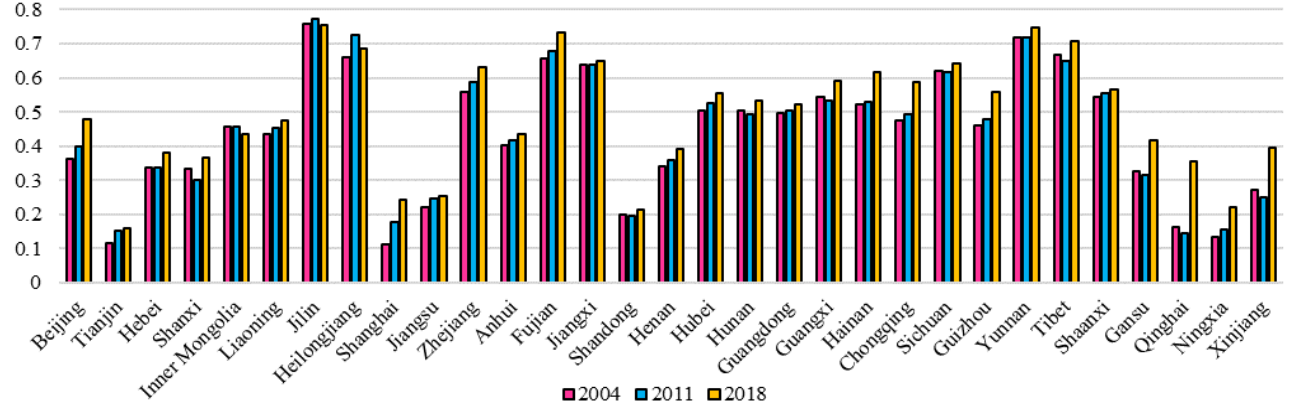
Figure 3. State index of forest ecological security.